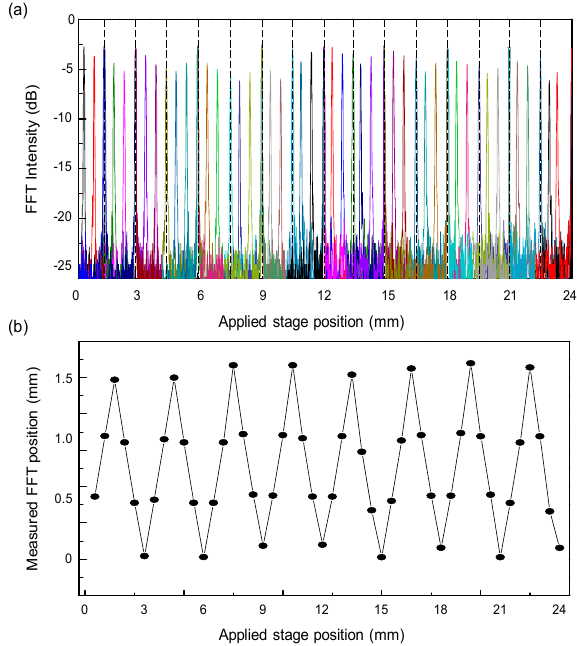
Figure 7. ( a ) Trace of FFT intensity of the proposed WCSL for applied stage positions from 0.5 to 23.5 mm; ( b ) Relationship between the applied stage position and the measured FFT position.